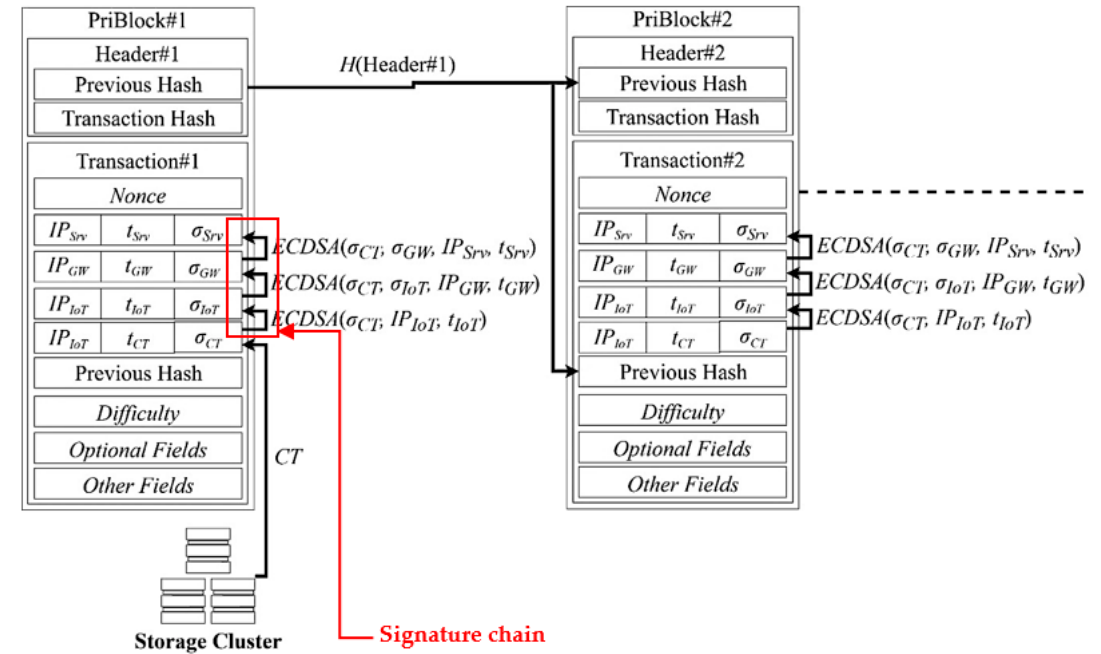
Figure 2. Private blockchain and signature chain in our system model.